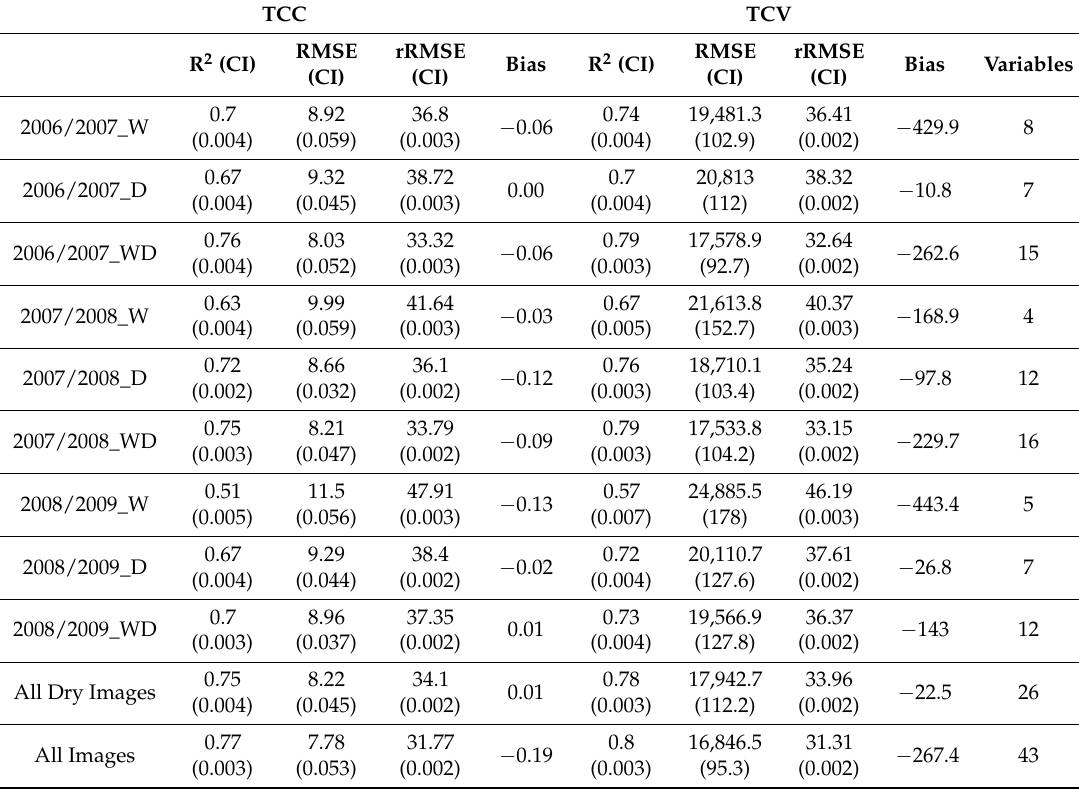
Table 3. Filtered random forest rRMSE results for different combinations of dry (D) and wet (W) period imagery within each phenological cycle, and for both the TCC and TCV LiDAR